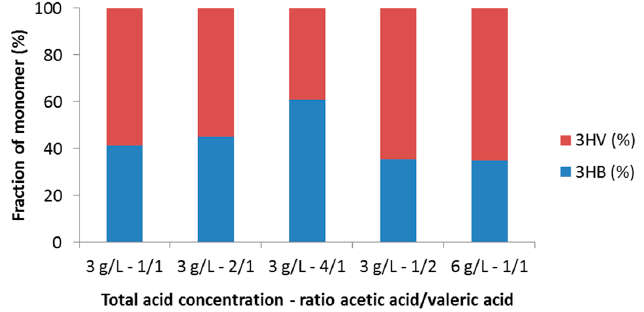
Figure 3. Effect of ratio acetic to valeric acid on PHBV content of C. necator in shake flask after 24 h of incubation. Results are shown as average of two independent experiments. Standard deviation (not shown) was smaller than 2.5%. Table 2. Consumption rate of acetic and valeric acid during PHB production of C. necator in shake flask. Total Acid Concentration (g/L) C2:C5 Ratio Acetic Acid (g/L/h) Valeric Acid (g/L/h) 1:1